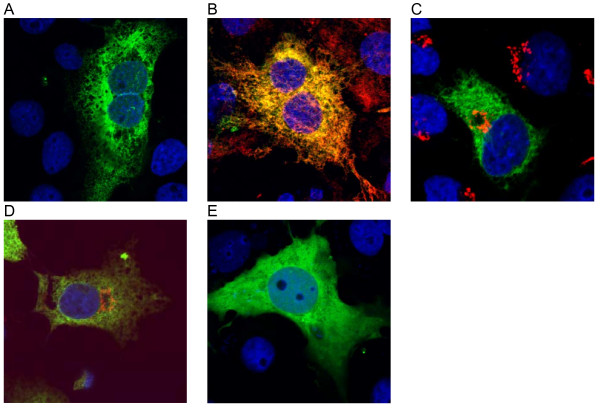
Subcellular localization of fibin in COS-7 cells. Confocal fluorescence images (LSM 510, Zeiss) show (A) fibin-GFP, (B) merge (yellow) of fibin-GFP (green) with the ER marker calnexin (red), (C) merge (yellow) of fibin-GFP (green) with the Golgi marker GM130 (red), (D) merge (yellow) of fibin, detected with anti-fibin-antibody-1/anti-rabbit-IgG-FITC (green) and the Golgi marker GM130 (red), and (E) Δ1-27-fibin-GFP.